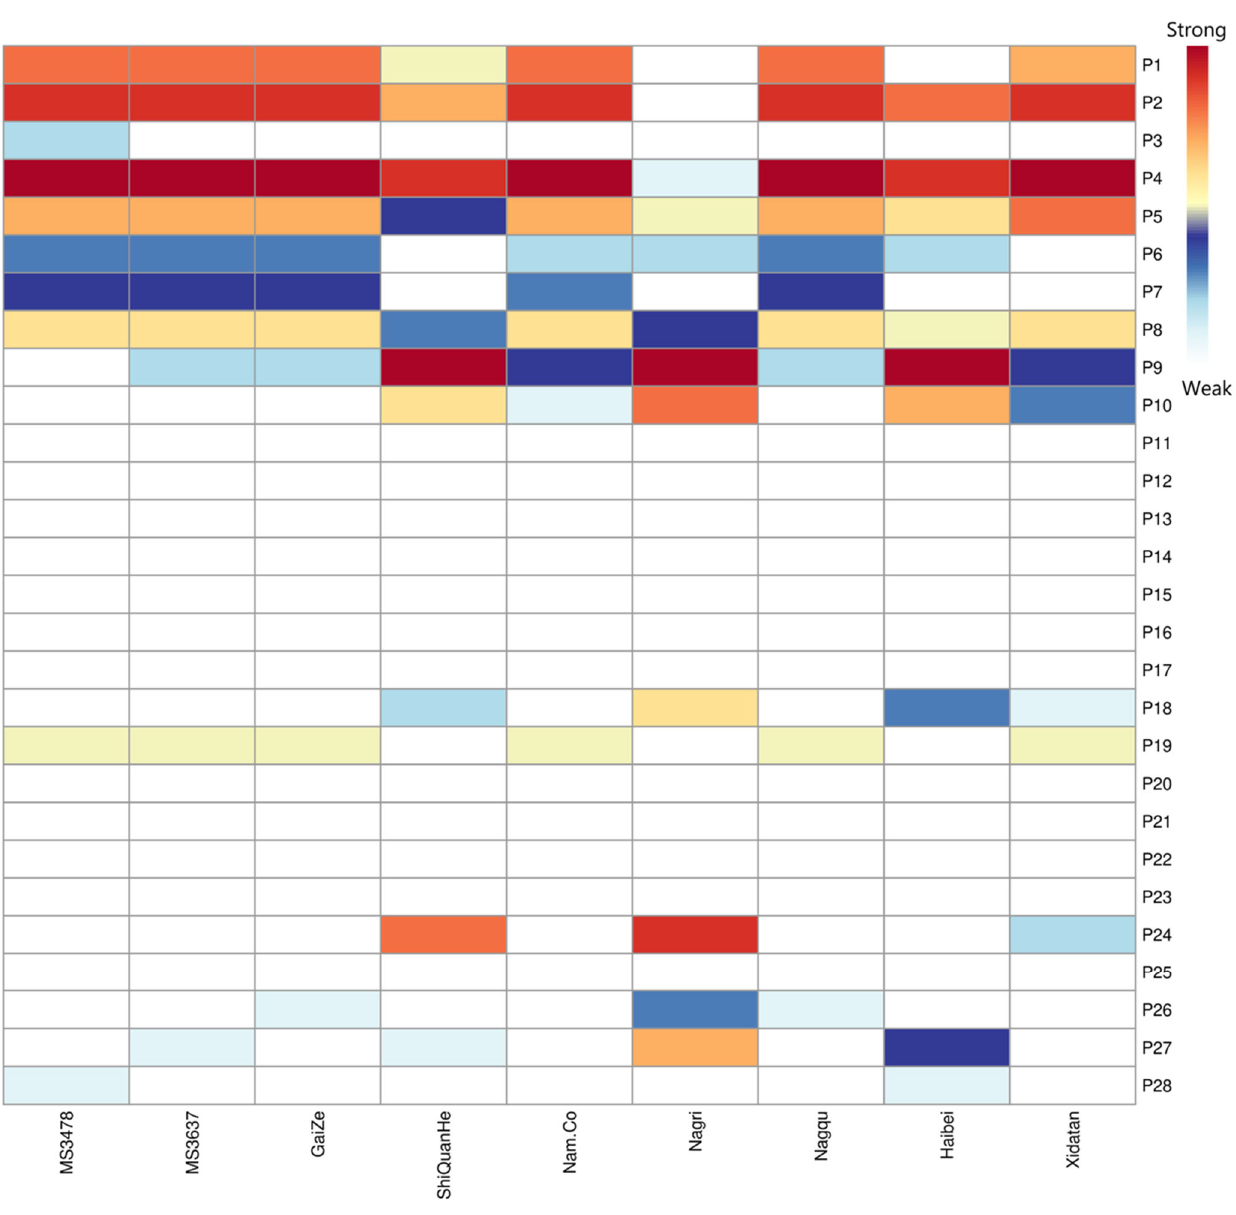
Figure 4. The sensitivity of each parameter using CNOP-P method over the TP (From research findings by Sun et al. [48]. Parameter corresponding to the number can be found in studies by Sun et al. [48] and Table S2 in Supplementary Materials).